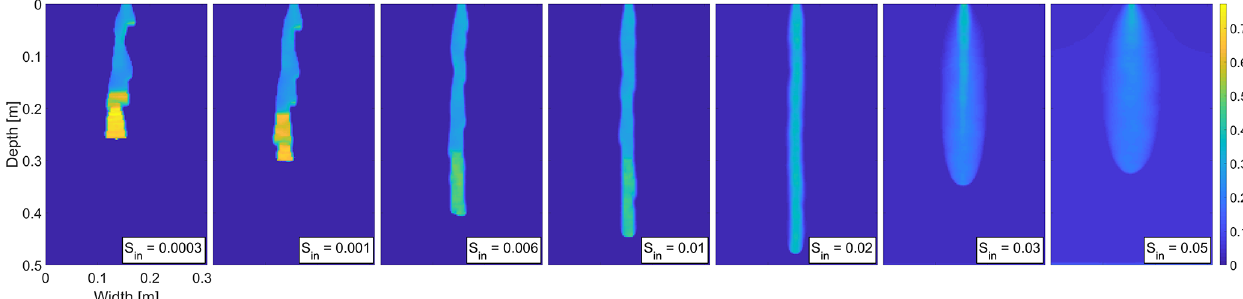
Figure A4. Snapshot of the saturation field at 25min for seven different values of the initial saturation for the distribution which satisfies κ max /κ min ≈ 2 . 50 (the distribution in Fig. A2b). Saturation values are color coded according to the color bar on the